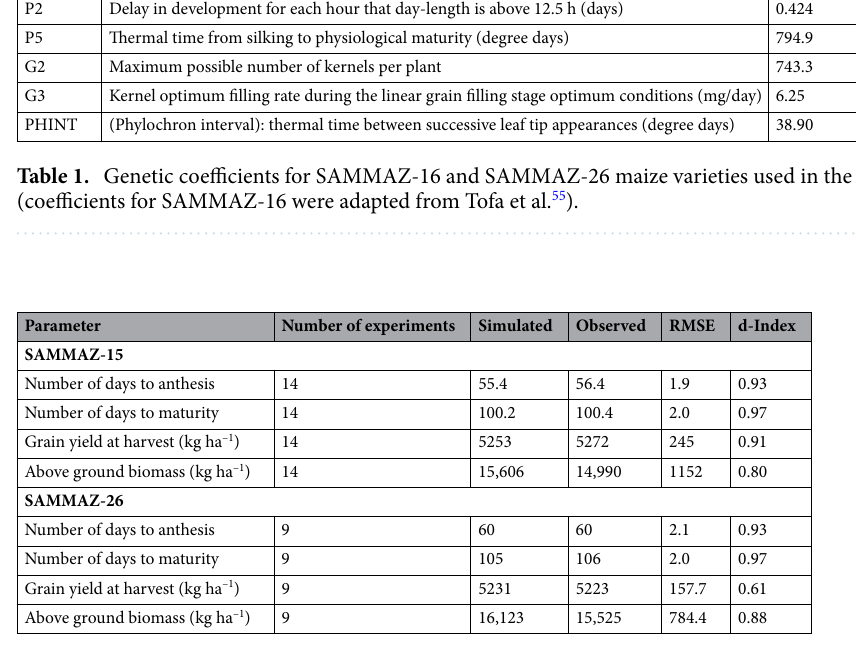
Table 2. Simulated and observed mean values for anthesis, physiological maturity, grain yield, and above ground biomass with their respective statistical indices for the calibrated maize varieties (values for SAMMAZ-16 Adapted from Tofa et al. 55